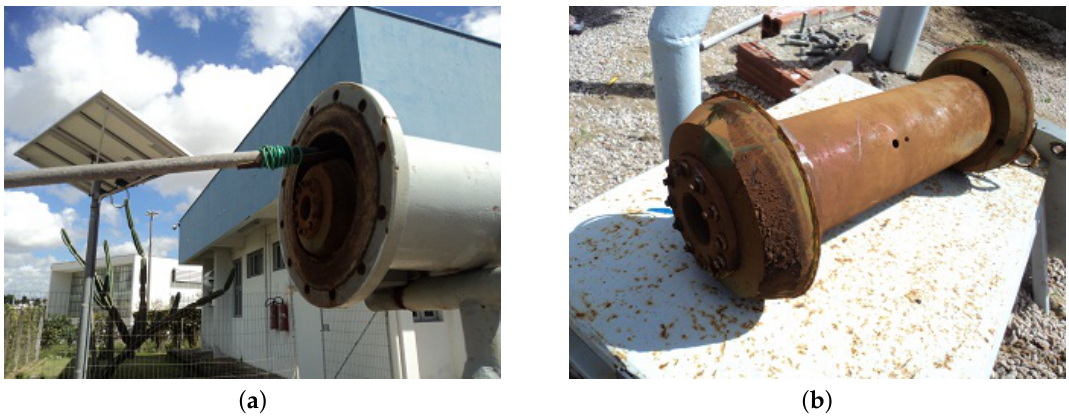
Figure 11. Procedures with the prototype PIG in the φ 8” receiver. ( a ) inserting a hook to pull the PIG; ( b ) PIG out from the receiver. Source: By